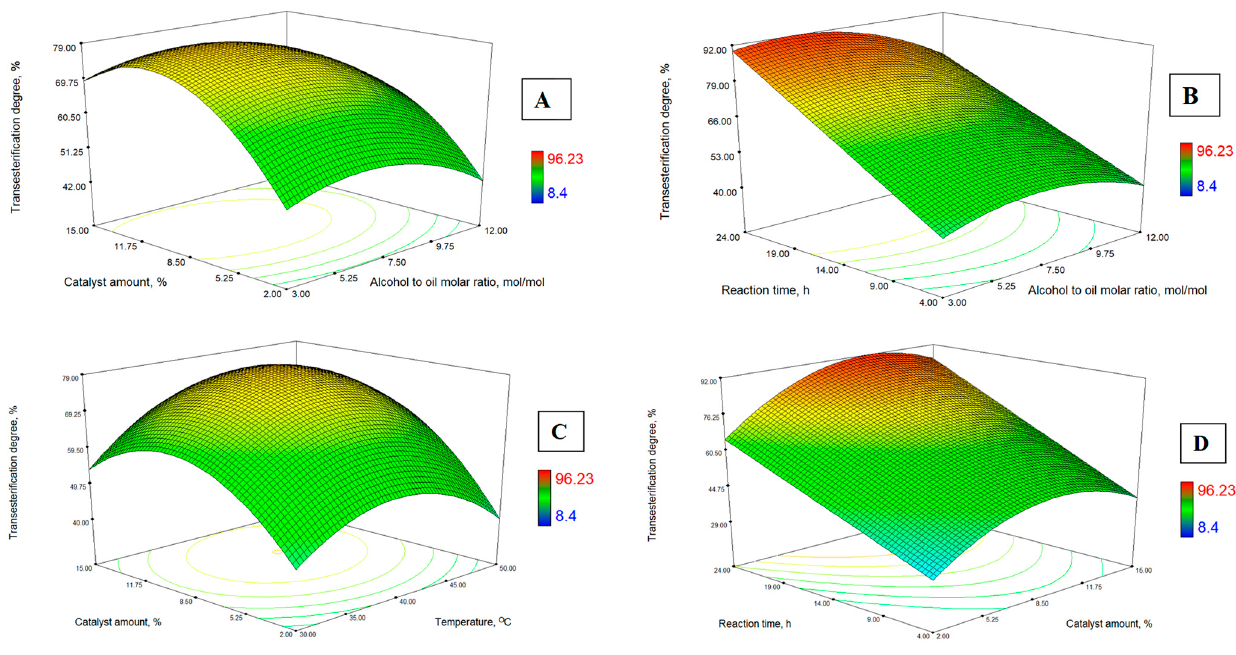
Figure 3. Response surface contour plot for the interaction between: ( A )—the molar ratio of alcohol to oil and catalyst amount, ( B )—the molar ratio of alcohol to oil and reaction time, ( C )—the temperature and catalyst amoun, ( D )—the catalyst amount and reaction time.